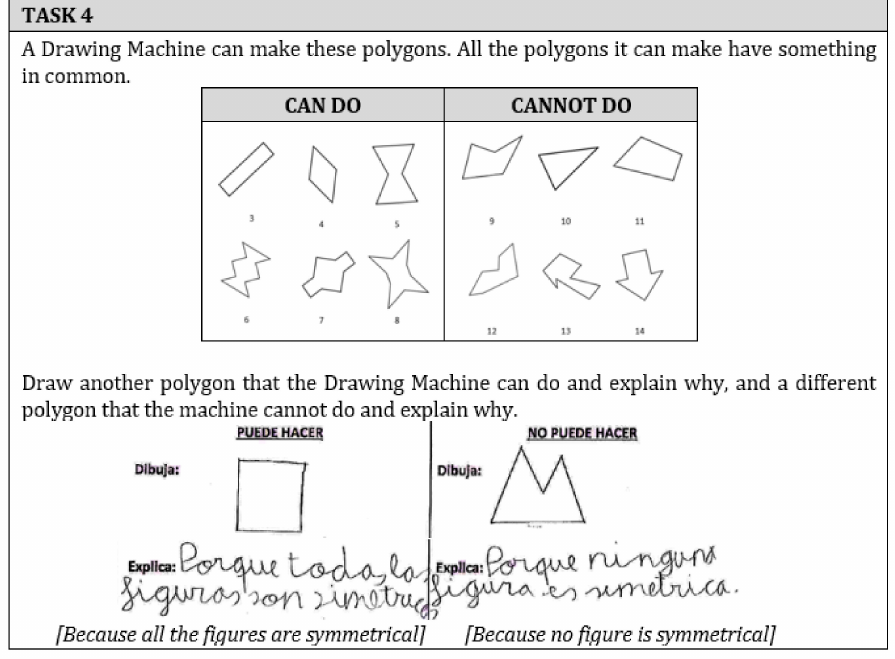
Figure 17. The answer given by student G2S27 when performing the task of identifying the common attribute into a set of polygons (having two axes of